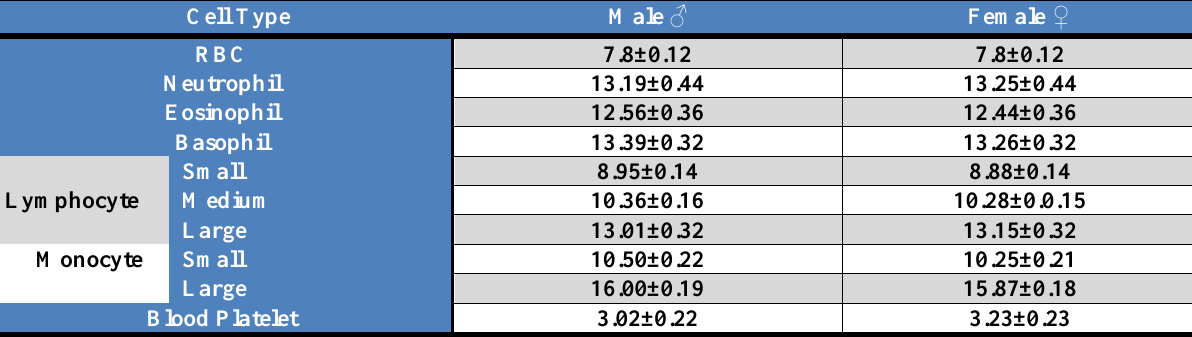
Table, 3: The results of cell diameter for RBC, Neutrophils, Eosinophils, Basophils, Lymphocytes, Monocytes, and Blood Platelet in µm in four groups of vervet